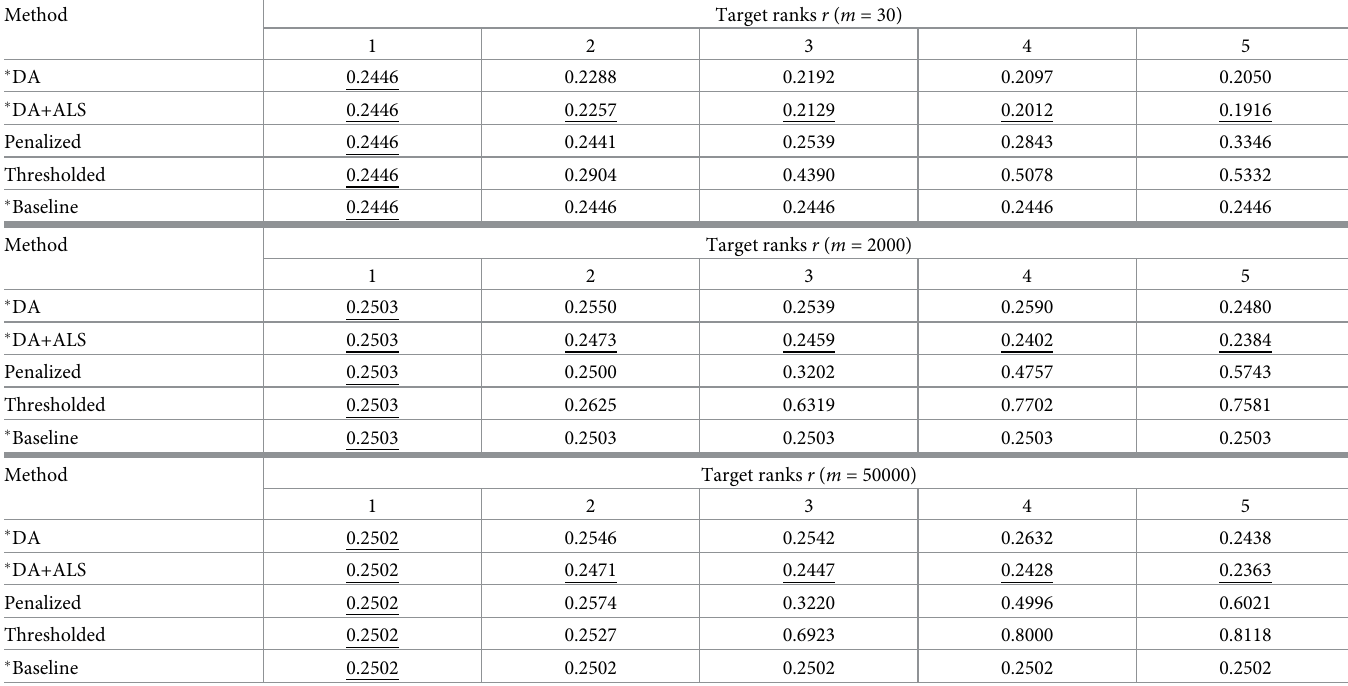
* Bernoulli(0.8). The � symbol indicates methods we propose. Best results are ij